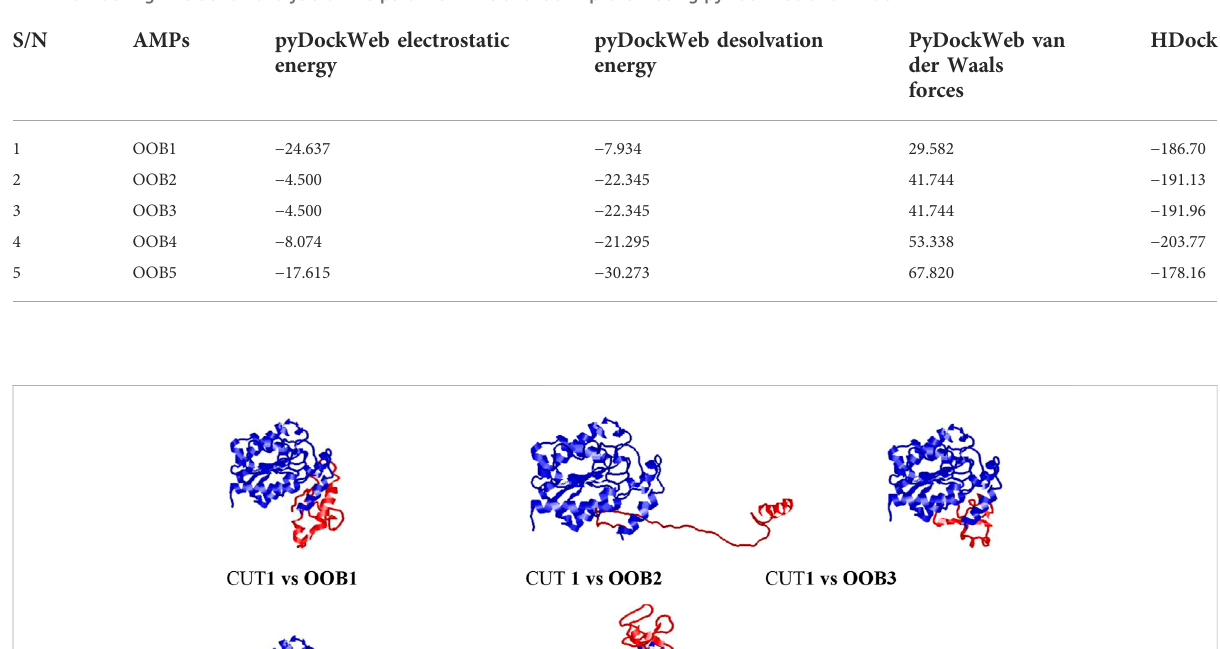
TABLE 8 Docking interaction analysis of the putative AMPs and CUT1 protein using pyDockWeb and HDock.